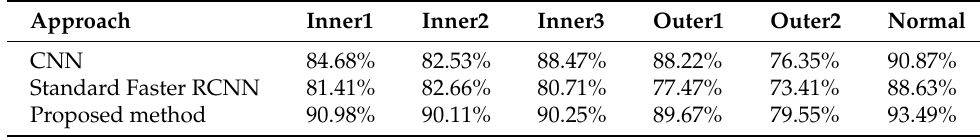
Table 10. Diagnosis accuracy of each condition.